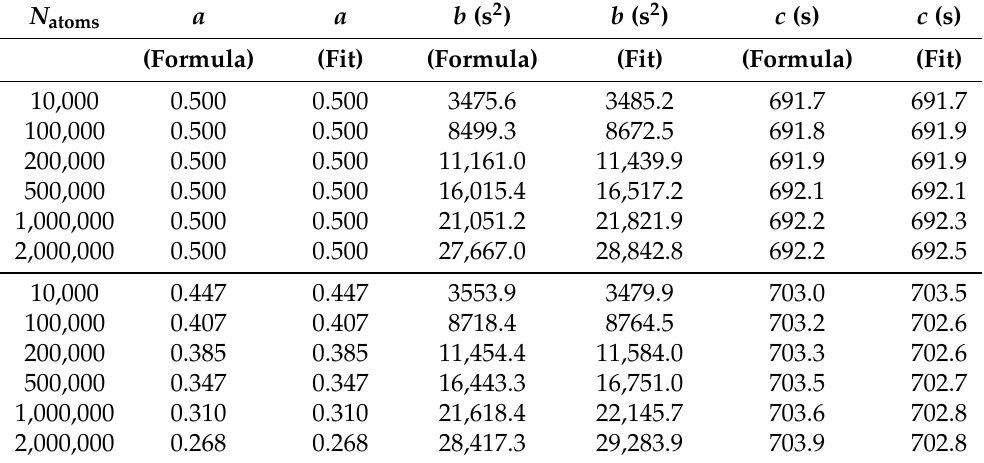
Table 2. Comparison of the fitted values of the parameters, a , b , and c with their values predicted by Equations (26)–(28) when cloud–cloud interactions are turned on. The top half of the table gives results for a harmonic potential and the bottom half for anharmonic